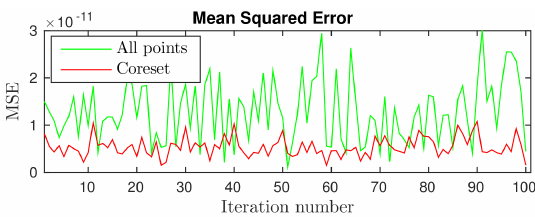
Figure 3. Comparing the results of methods (i) and (ii). The X -axis represents the number of iterations. The Y -axis represents the Mean Squared Errors between the two sets after applying the optimal poses obtained from each of the two